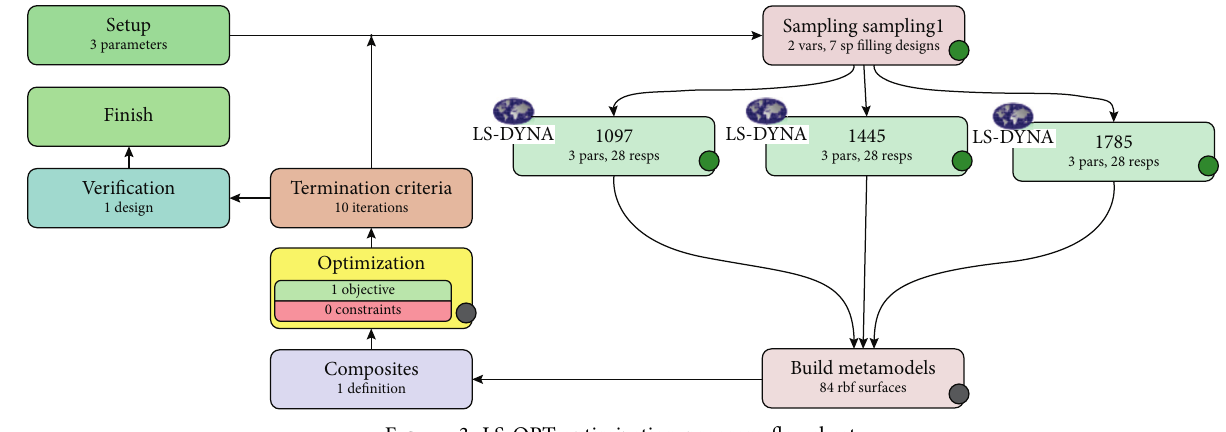
Figure 3: LS-OPT optimization program flowchart. Table 6: Chemical reaction kinetic parameters of reactive materials obtained by fitting with adaptive simulated annealing algorithm. Ea [J · mol − 1 ] n